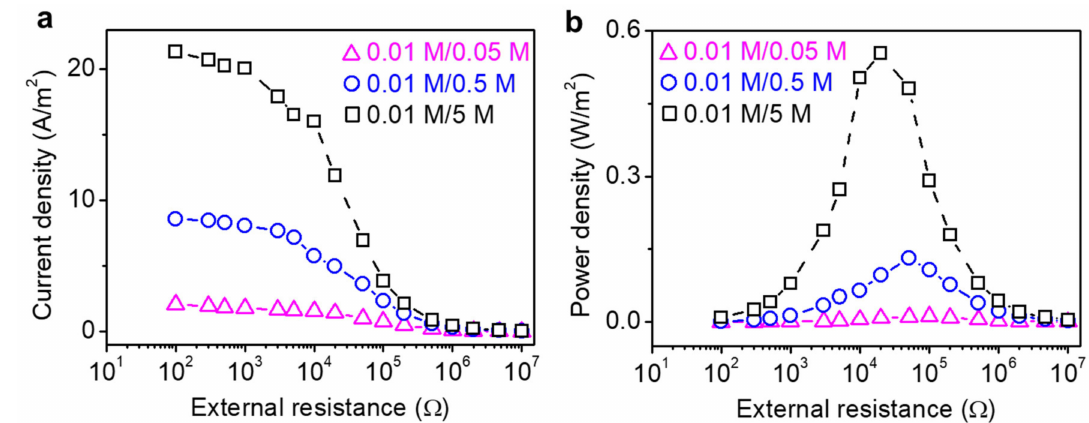
Figure 6. GO–CA membrane-based power generator for osmotic energy harvesting. Current density ( a ) and power density ( b ) of GO–CA heterogeneous membrane with different NaCl salinity